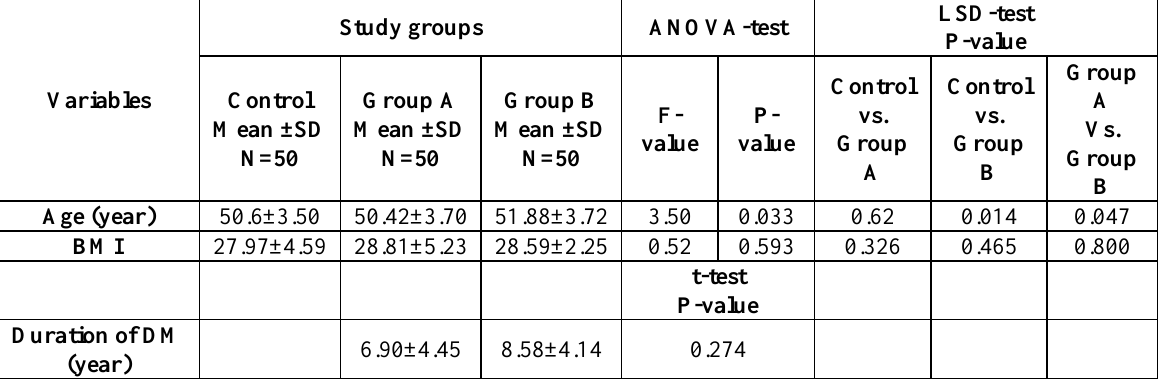
Table 1: Clinical characteristics of type 2 diabetic patients according to arterial stiffness index (ASI) in comparison with controls